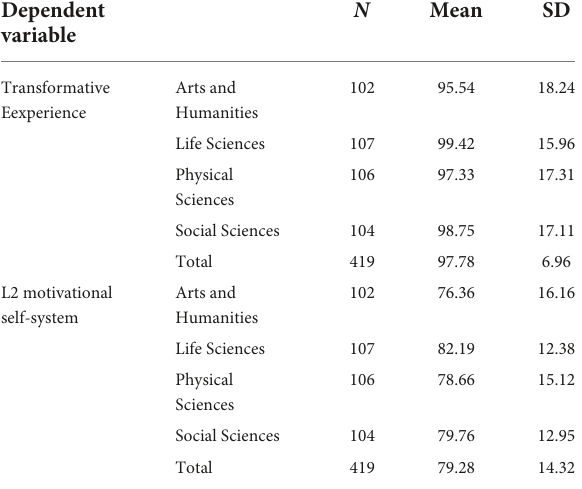
TABLE 7 Descriptive statistics of transformative experience and L2 motivational self-system across disciplinary groups.